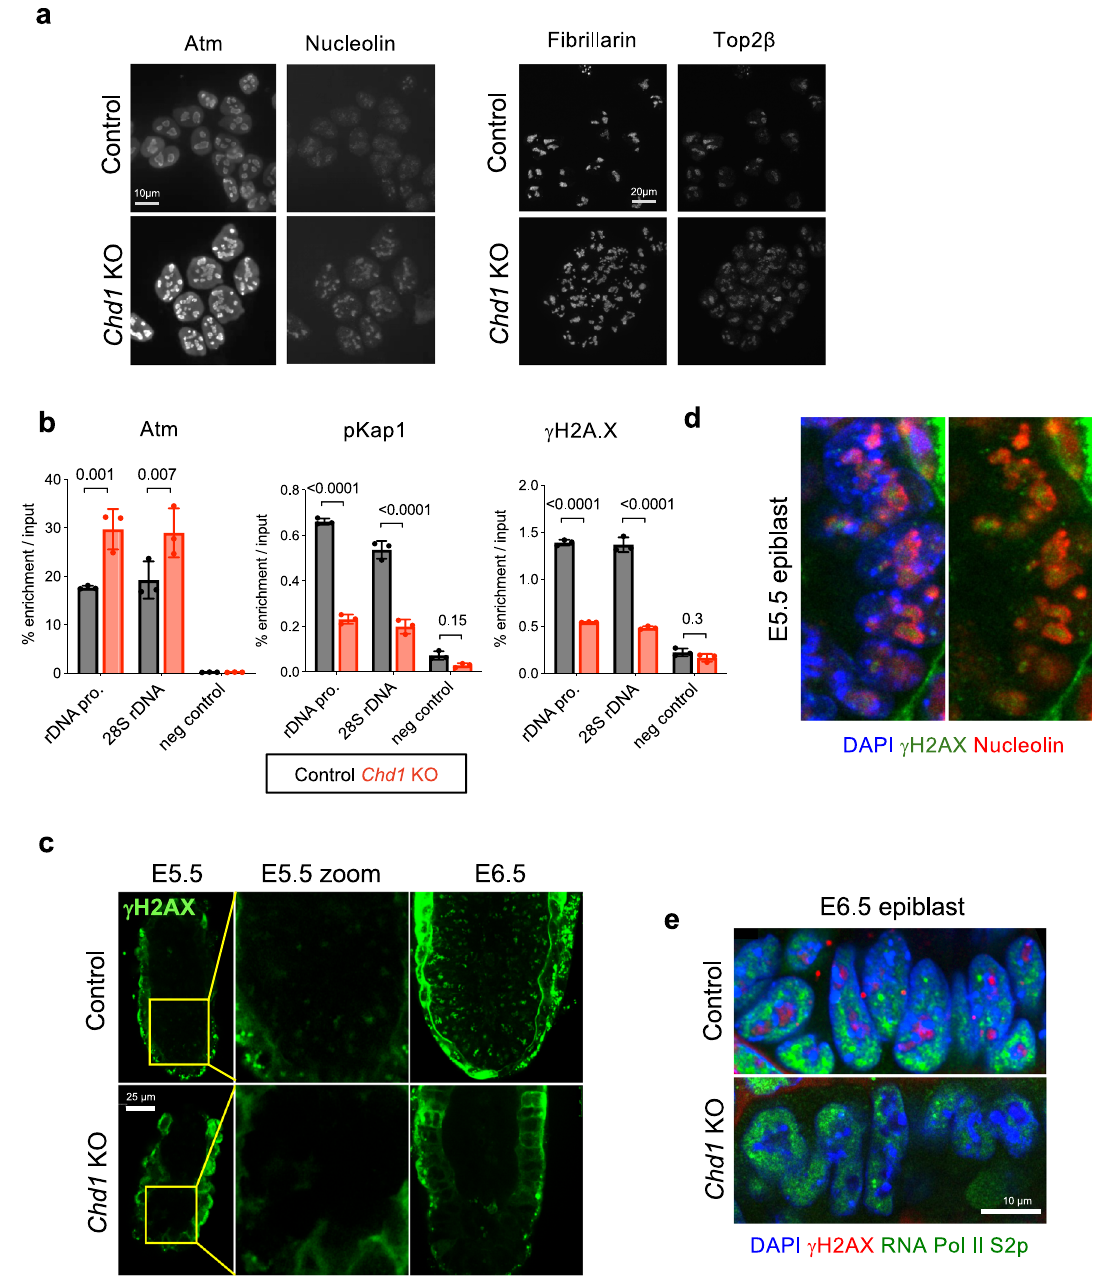
Fig. 2 DNA repair signaling is perturbed in Chd1 KO ES cells. a Immuno fl uorescence analysis of Chd1-interacting DNA repair proteins Atm and Top2 β in control and Chd1 KO cells. Nucleolin and fi brillarin co-stainings mark the nucleoli. Note the fragmentation of nucleoli in Chd1 KO ES cells, as we have previously reported 3 . Figure is representative of two biologically independent experiments. b ChIP-qPCR analysis of selected DNA repair proteins at rDNA. N = 3 biologically independent experiments. Graphs show mean and standard deviation. Statistical tests performed are two-way ANOVA with Sidak ’ s correction. Values above bars indicate p -values. c γ H2A.X staining of control and Chd1 KO mouse embryos at E5.5 and E6.5. N = 4 (minimum) biologically independent embryos. d γ H2A.X and Nucleolin staining of the control E5.5 epiblast, showing nucleolar localization of the γ H2A.X signal. N = 4 (minimum) biologically independent embryos. e γ H2A.X and elongating RNA Pol II (S2p) staining of the E6.5 epiblast in control and Chd1 KO embryos. N = 4 (minimum) biologically independent